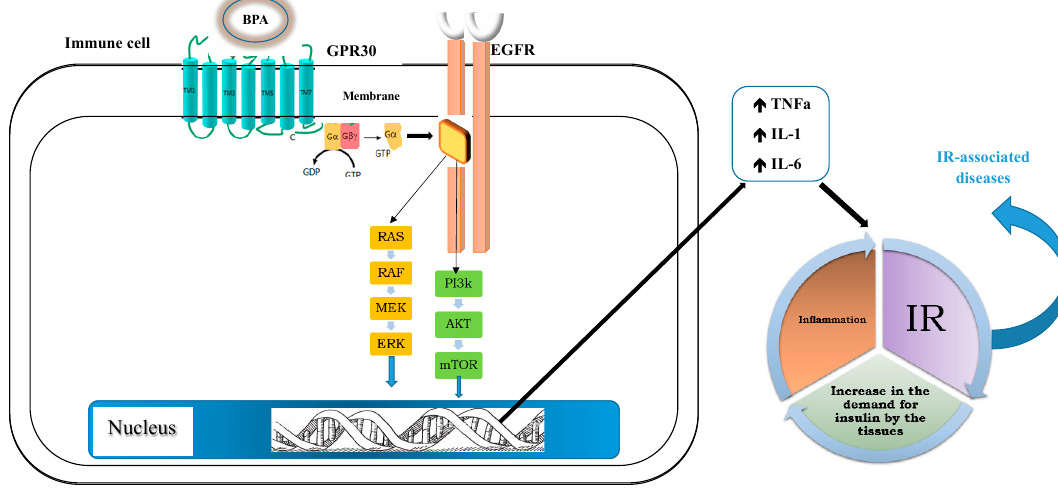
Figure 2. BPA-mediated G protein-coupled receptor 30 (GPR30) activation and relative e ff